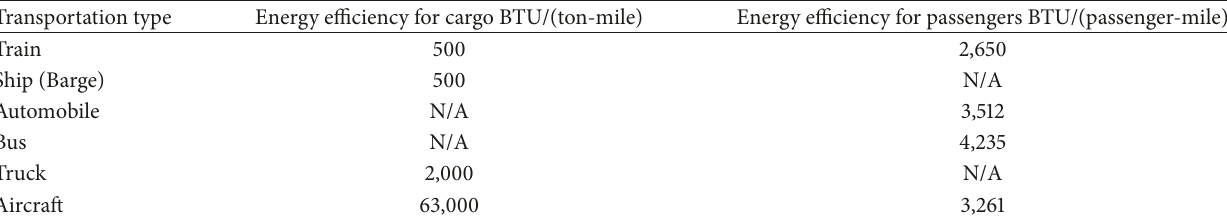
Table 1: Energy use for cargo and